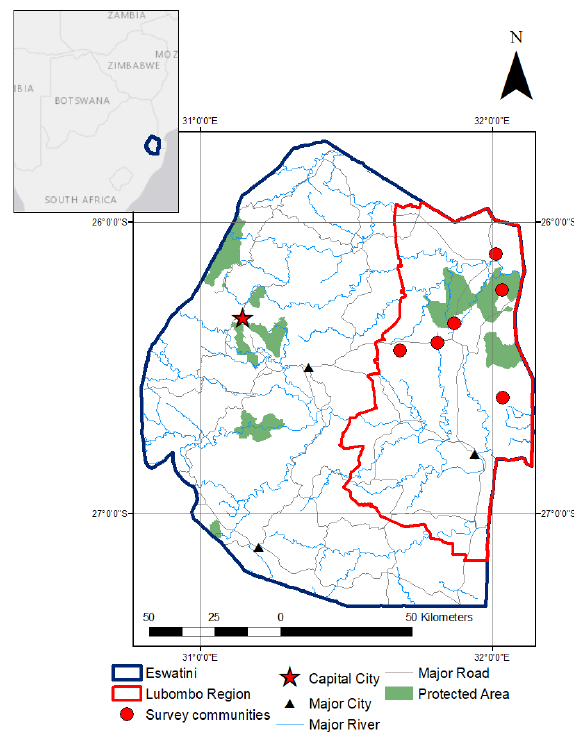
Fig. 1. Map of Eswatini showing the Lubombo region and locations of the communities surveyed. Inset: Map showing the location of Eswatini in relation to its neighbouring countries in